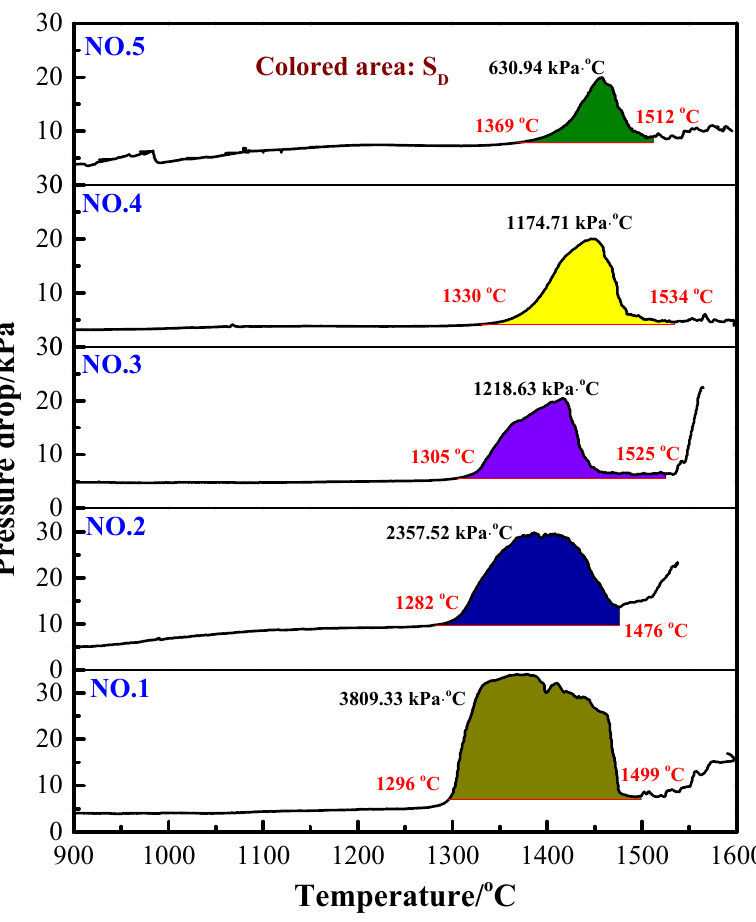
Figure 4. Gas permeability index (S D ) for reducing gas with different H 2 contents.